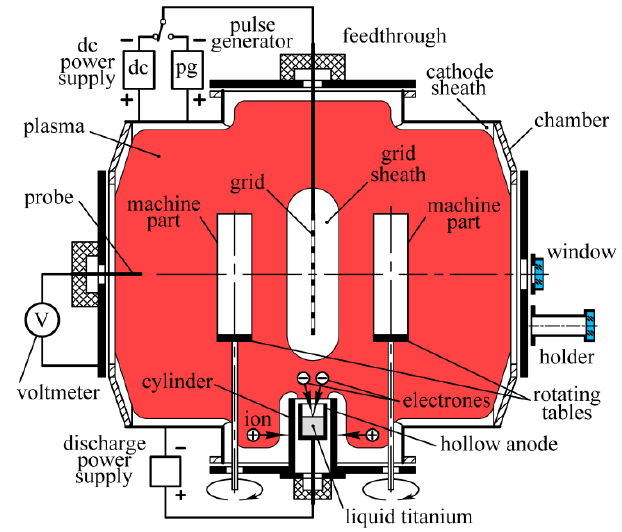
Figure 1. Schematic diagram of the experimental setup.